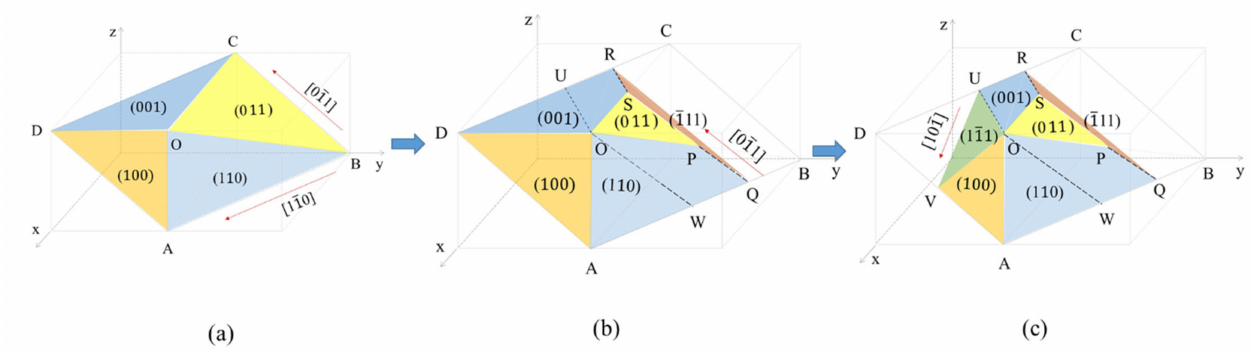
Figure 5. M 23 C 6 carbide morphology at the phase boundary developed from ( a ) to ( b ) to finally ( c ) based on diffraction pattern and carbide angle in TEM image. Basal plane of the M 23 C 6 carbide is the (111)